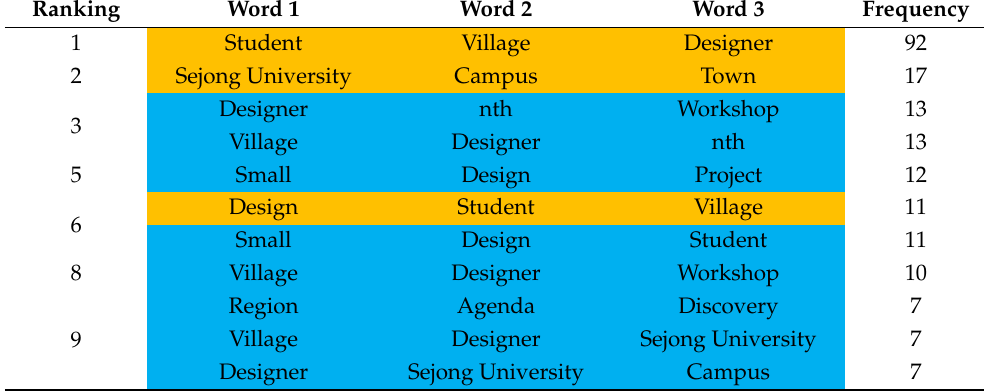
Table 2. Frequency of words (nouns) mentioned by each